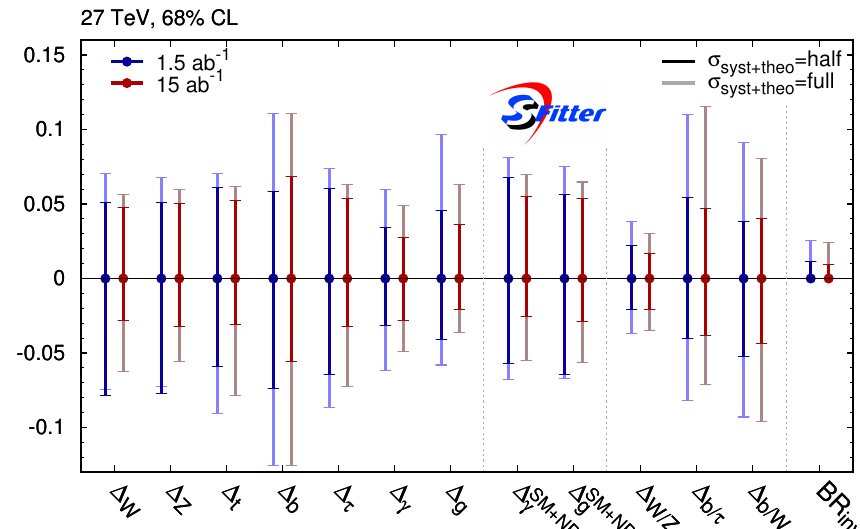
Figure 1: Result from the global Higgs analysis in terms of coupling modifiers or non- linearly realized electroweak symmetry breaking. All limits are shown as profiled over all other